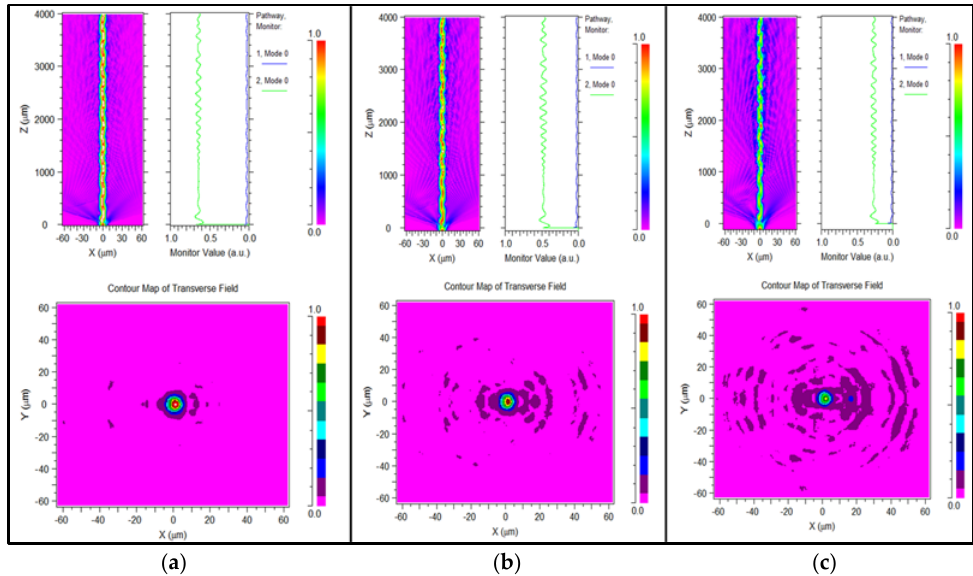
Figure 8. The optical field distribution of fiber moving up in Z-axis. ( a ) is the distribution of optical field when the end-face of fiber is at the focal point of the LD TO, Z = 0 µ m. ( b ) is the distribution of optical field at the maximum power where the fiber moves up 60 µ m along Z-axis, Z = 60 µ m. ( c ) is the distribution of optical field at the maximum power where the fiber moves up 120 µ m along Z-axis, Z = 120 µ m.